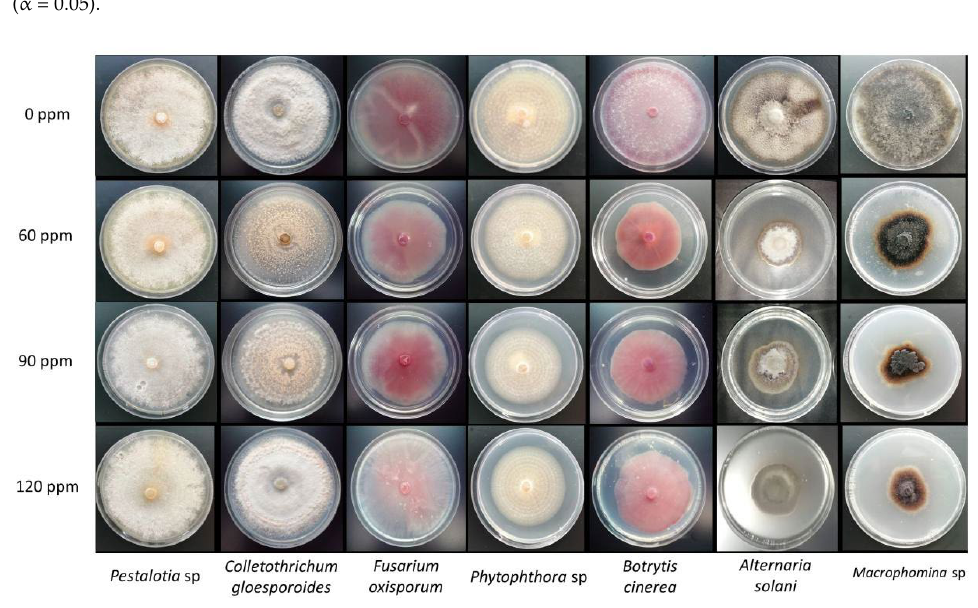
Figure 2. Mycelial growth of phytopathogenic fungi at different AgNP concentration rates, synthesized from the extract of L. tridentata.